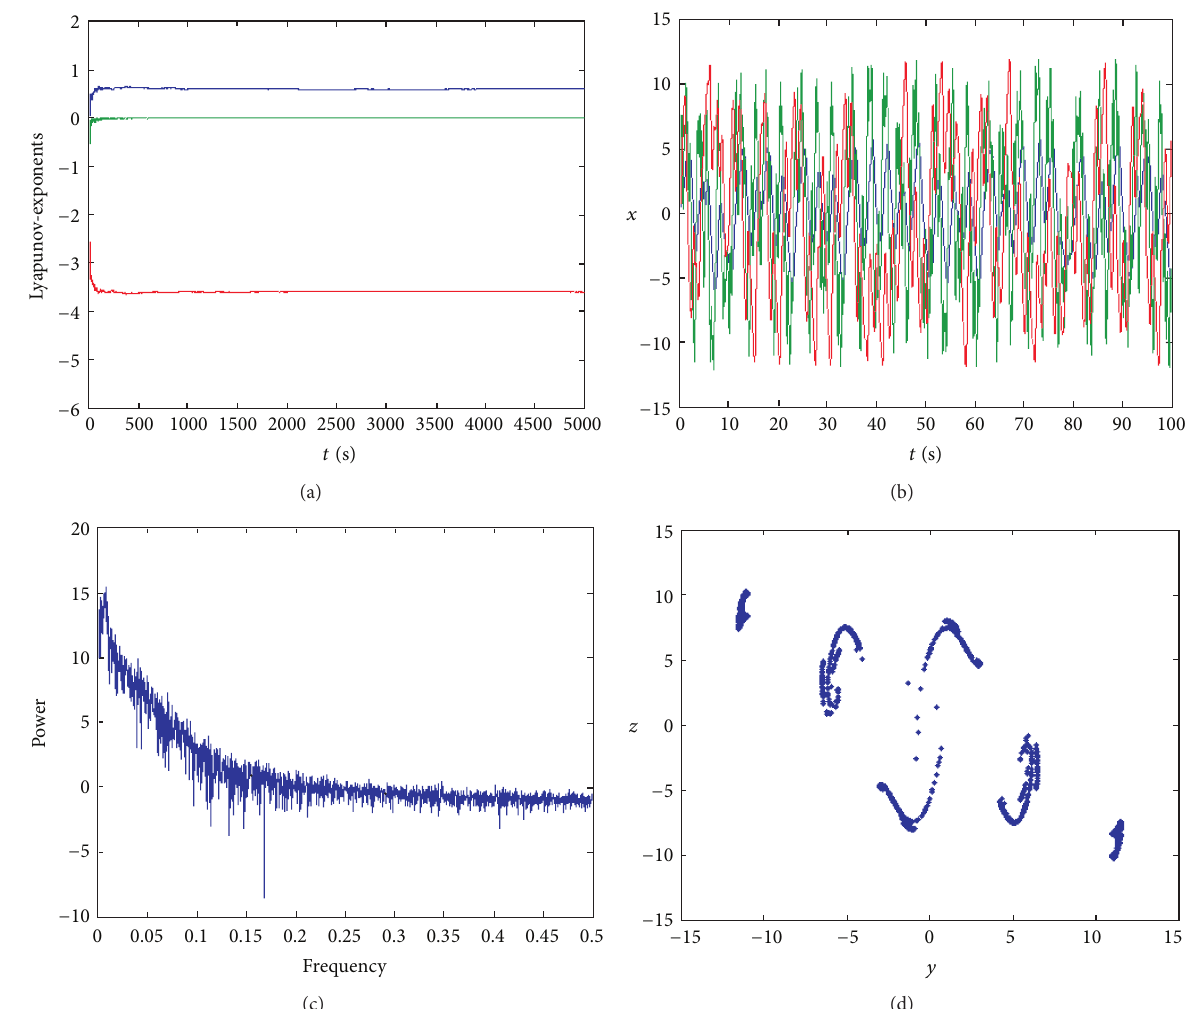
Figure 2: (a) Time history, (b) frequency spectrum, (c) Poincar´e mapin 𝑦−𝑧{𝑥 = 0} plane, and (d) Lyapunov-exponent spectrum of chaotic system